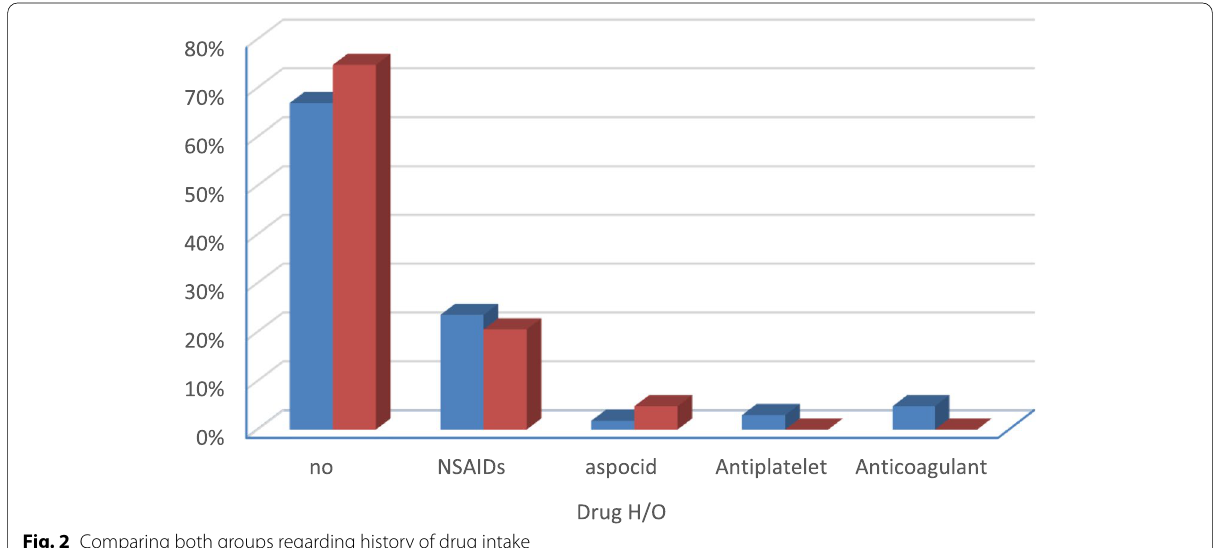
Fig. 2 Comparing both groups regarding history of drug